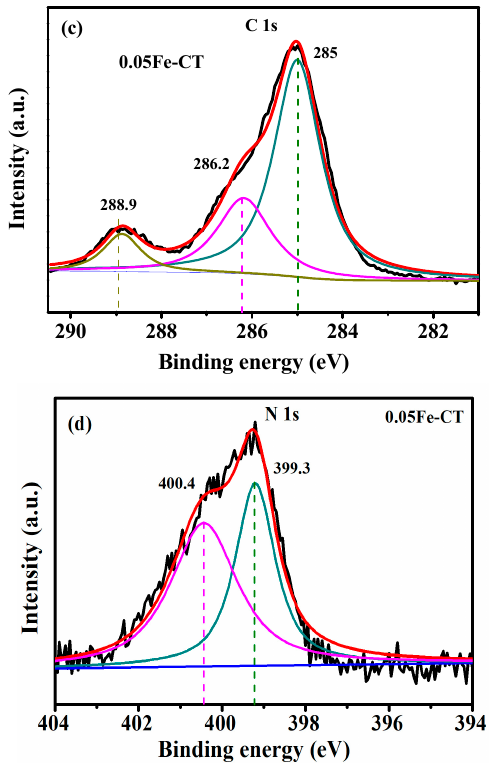
Figure 6. High resolution XPS spectra of ( a ) Ti 2p, ( b ) O 1s, ( c ) C 1s, and ( d ) N 1s.